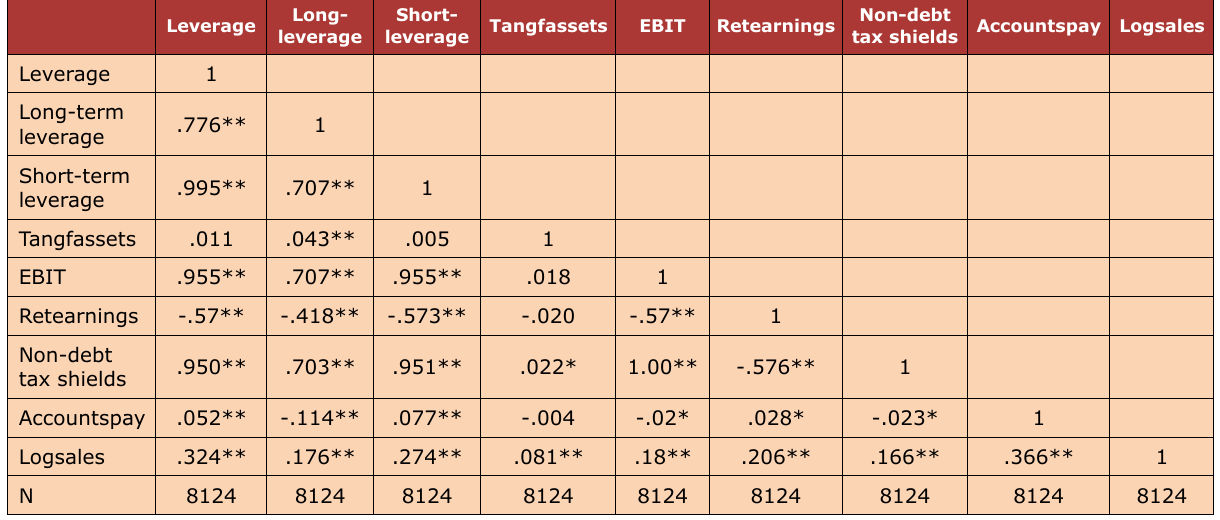
Table5. Correlations matrix, table of Pearson correlation test for each